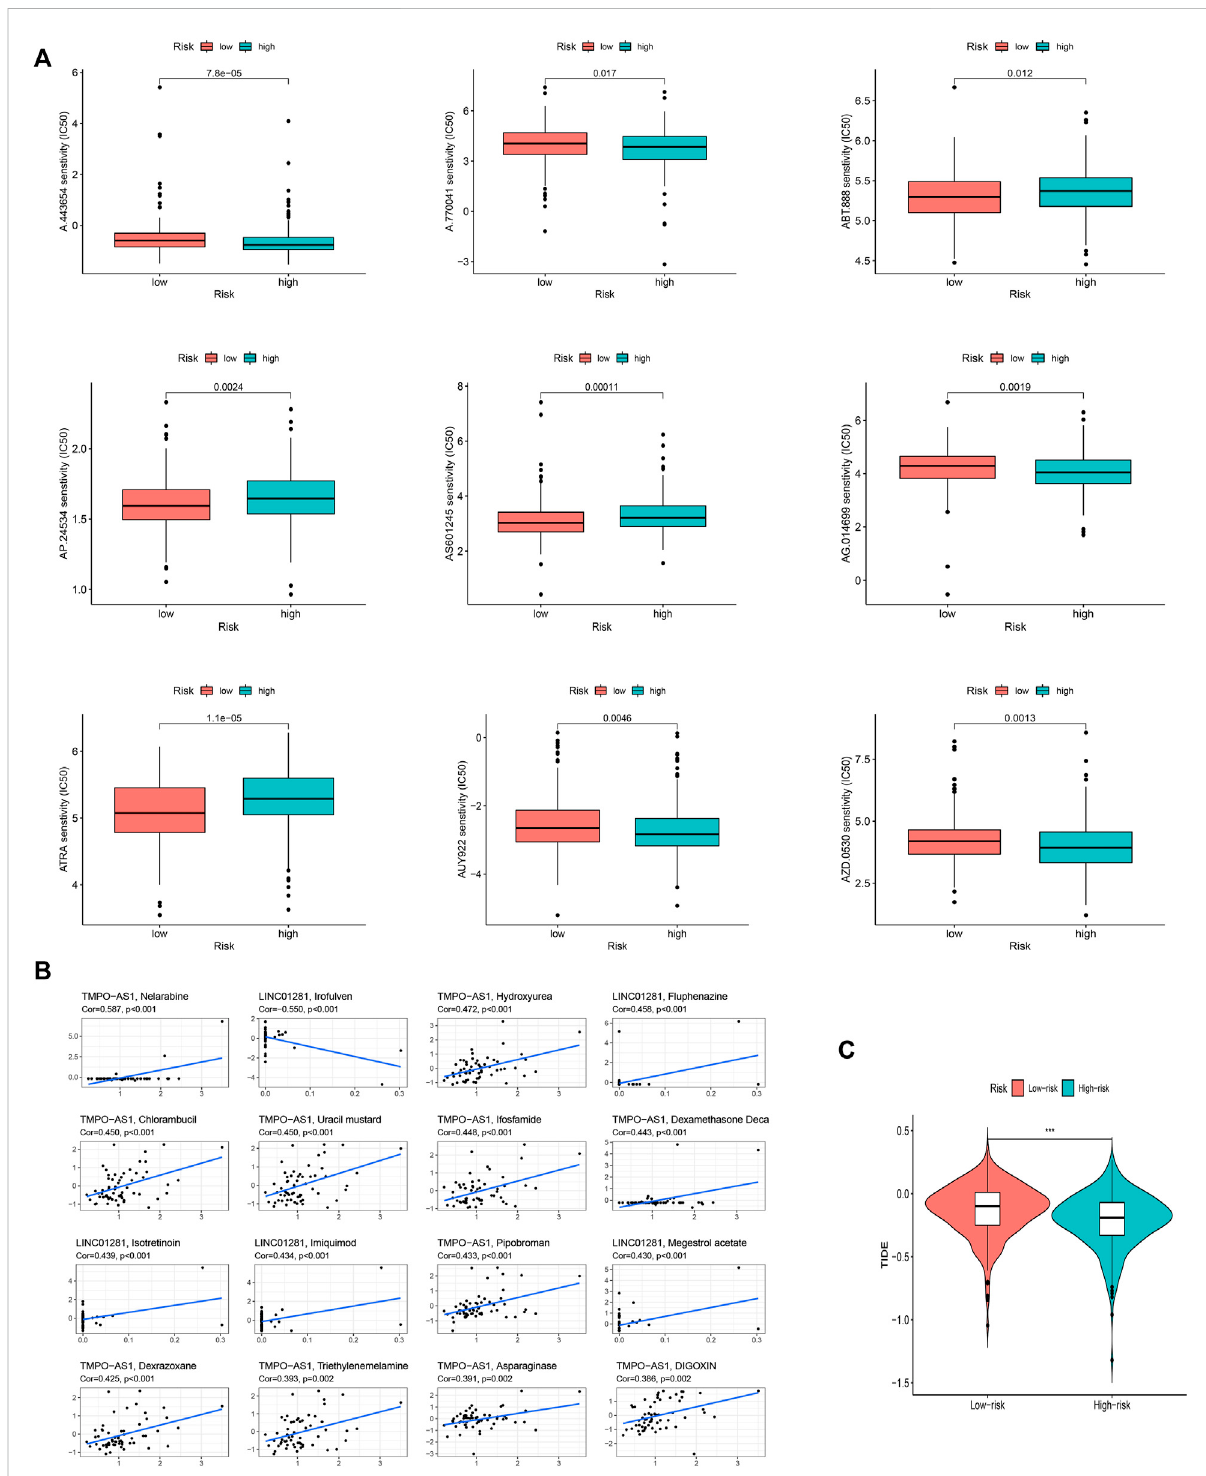
FIGURE 10 The investigation of tumor immune factors and immunotherapy. (A) The immunotherapy prediction of high-risk and low-risk groups. (B) The correlation between 12 FAM-related lncRNAs and drugs. (C) TIDE prediction difference in the high-risk and low-risk